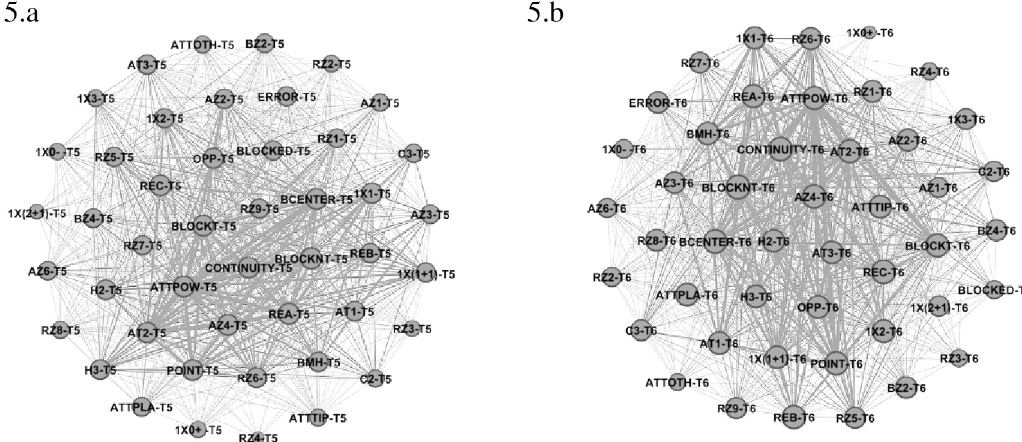
Fig 5. Sub-network with intra-team variability of Team 5 (5.a) and 6 (5.b).